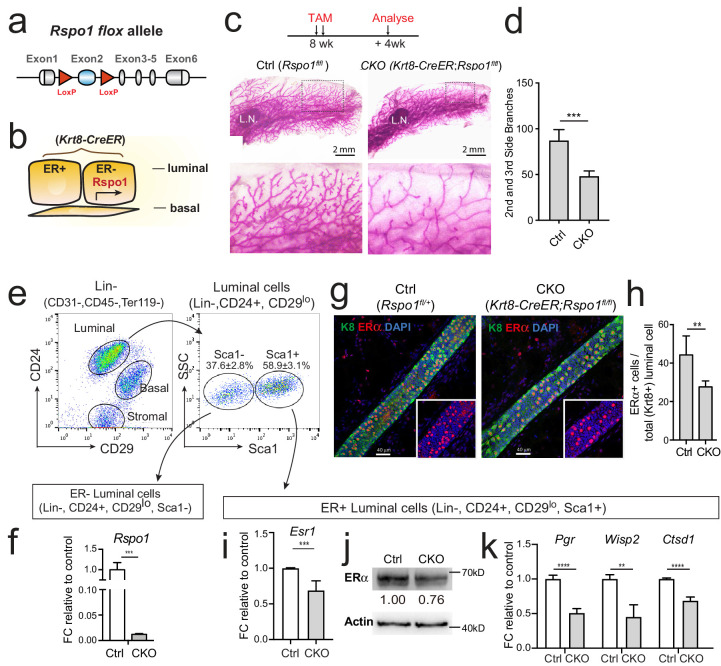
Loss of Rspo1 in mammary luminal cells results in reduced side branching and decreased ERα expression.(a) Schematic illustration of Rspo1flox knock-in allele generation (see also Figure 4—figure supplement 1). (b) Krt8-CreER;Rspo1fl/fl inducible model specifically knockdown Rspo1 in luminal cells. (c–d) 8-week-old adult virgin mice were Tamoxifen injected twice, 1 day apart (2 mg/25 g body weight per injection). Mammary glands were obtained 4 weeks later. Whole-mount imaging (c) of mammary epithelium and quantification (d) showing decreased side branches in Rspo1-cKO mice. n = 3. Scale bar, 2 mm. More than six views were used for quantification. (e–f) FACS gating strategy for mammary basal and luminal cell isolation. Luminal ER+ and ER- subpopulations were separated based on Sca1 (e). qPCR analyses of luminal cells showing efficient Rspo1 knockdown in Krt8-CreER;Rspo1fl/fl (f). (g–h) Immunostaining indicated decreased ERα+ cell number after Rspo1 knockdown (g). Scale bar, 40 μm. Quantification of ERα+ cells were performed in (h). (i) qPCR analyses of ER+ luminal cells indicated downregulation of Esr1 transcription after Rspo1 knockdown in ER- cells. (j) Sca1+ (ER+) luminal cells were FACS isolated and Western blot was performed to indicate decreased ERα expression after Rspo1 knockdown. (k) qPCR analyses of ER+ luminal cells indicated downregulation of ERα target genes after Rspo1 knockdown in ER- cells. Data are presented as mean ± s.e.m. of more than three independent experiments. Student’s t test: ****p<0.0001, ***p<0.001, **p<0.01, *p<0.05. L.N. Lymph node.